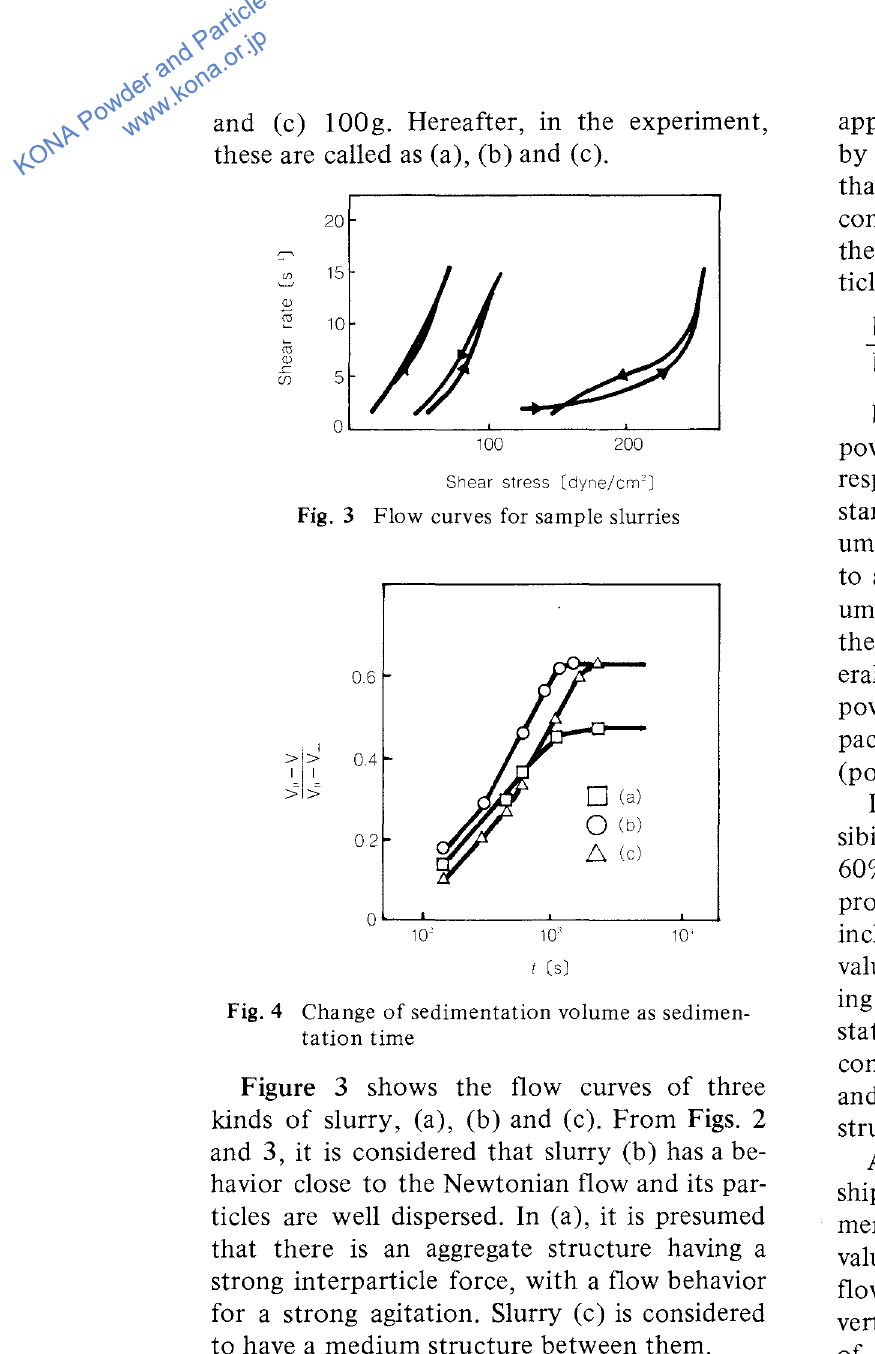
Table 1 Flocculation state of particles in